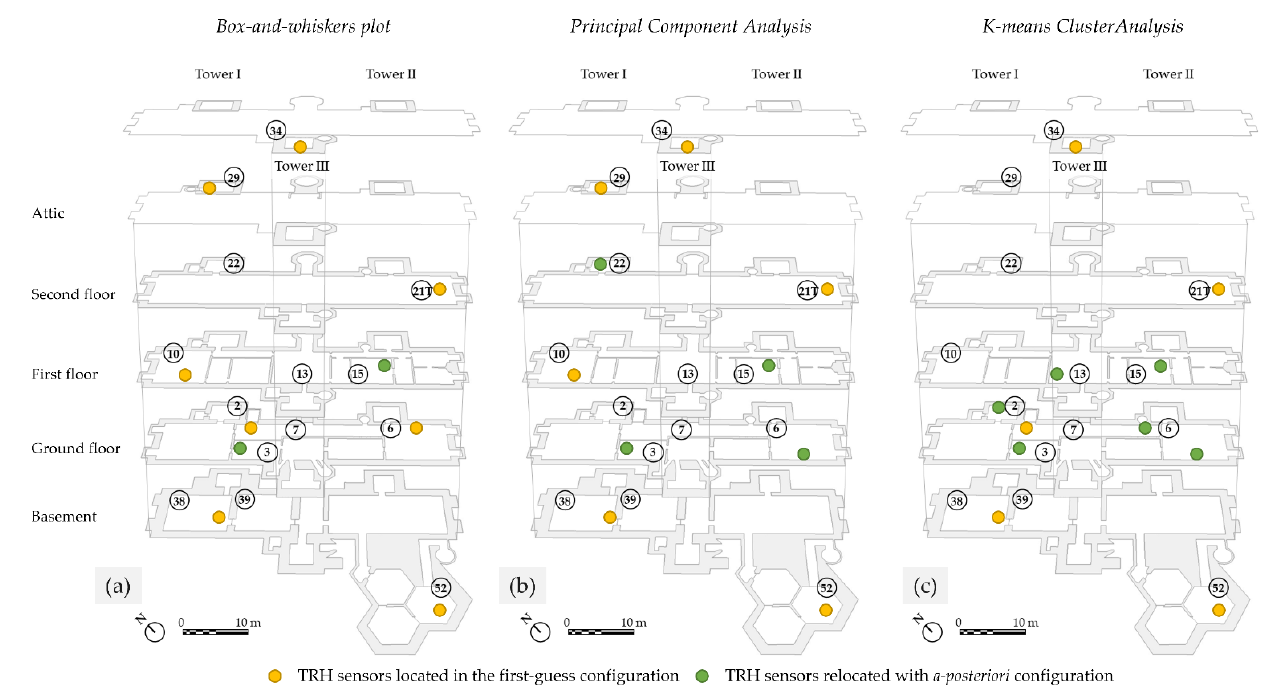
Figure 9. Plans of Rosenborg Castle. A posteriori deployment of the TRH sensors according to: ( a ) box-and-whisker plots, ( b ) principal component analysis, and ( c ) k-means cluster analysis.